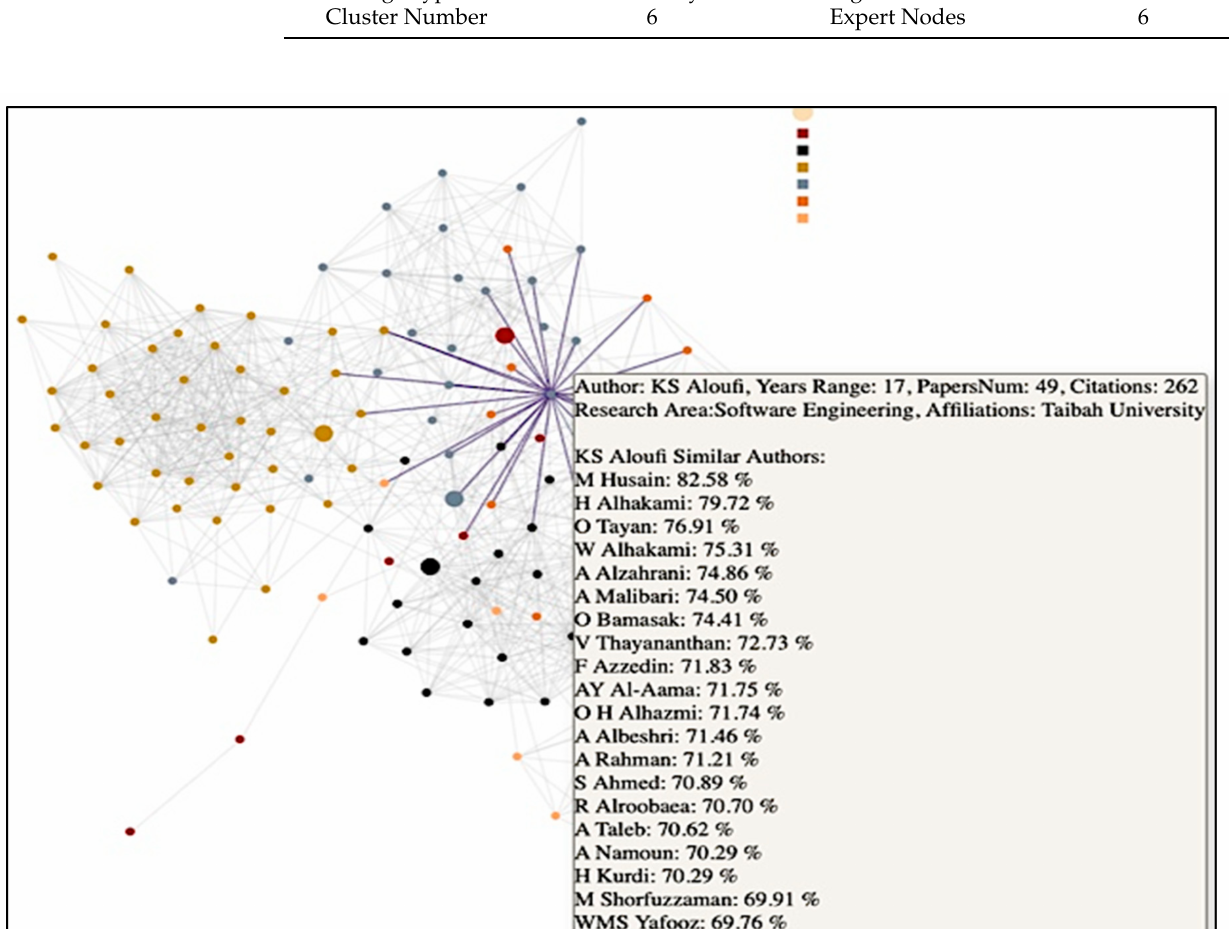
Figure 22. The author with the highest degree of centrality.